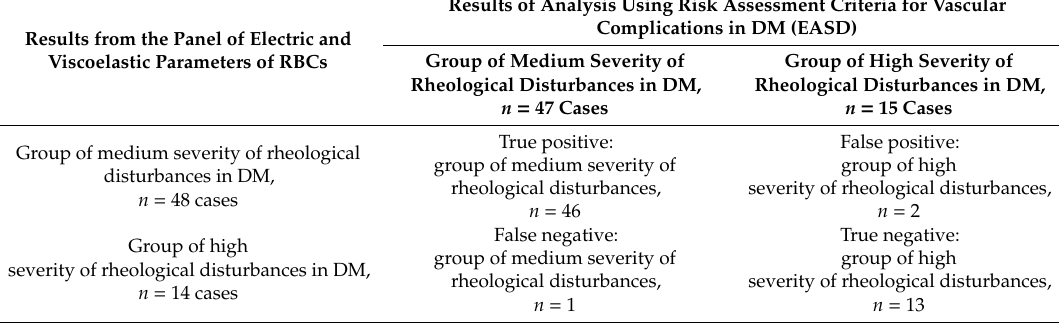
Table 4. Diagnostic performance of the panel of electric and viscoelastic parameters of RBCs in patients with type 2 DM for assessing rheological-disturbance severity, as compared with the risk assessment criteria for vascular complications in patients with DM according to the